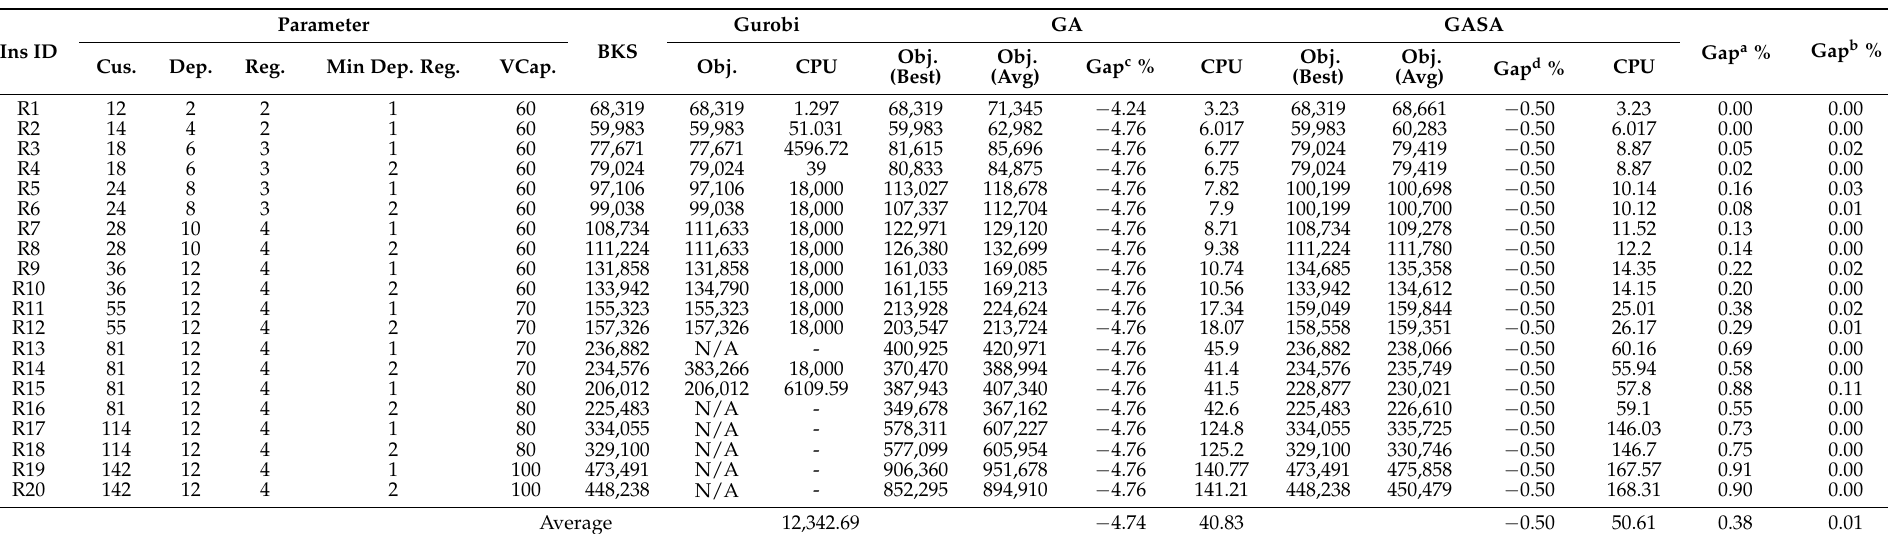
Table 3. Comparative objective value results for the RLRP